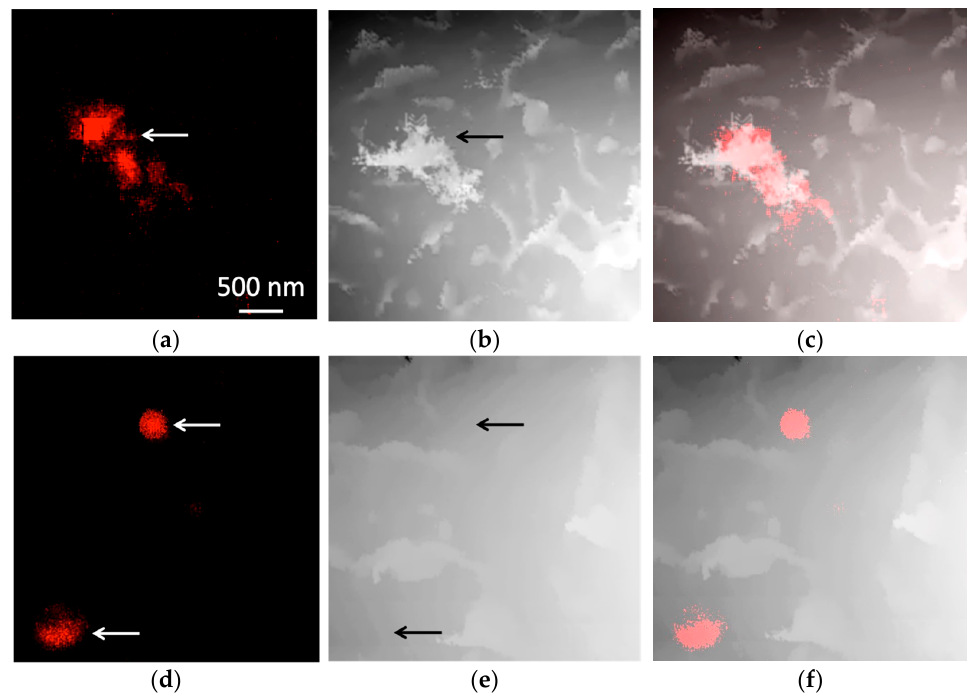
Figure 4. Magnetite–gold dumbbell nanoparticles interaction with cells. ( a – c ) MNP localization on the surface of cell plasma membrane; ( d – f ) MNP localization under the cell plasma membrane following their internalization. ( a , d ) Confocal laser scanning micrographs of MNPs modified with Cy5 dye; ( b , e ) topography micrographs of the same MNPs with cells, SICM; ( c , f ) merge of fluorescence and topography. Arrows show the MNPs of interest.